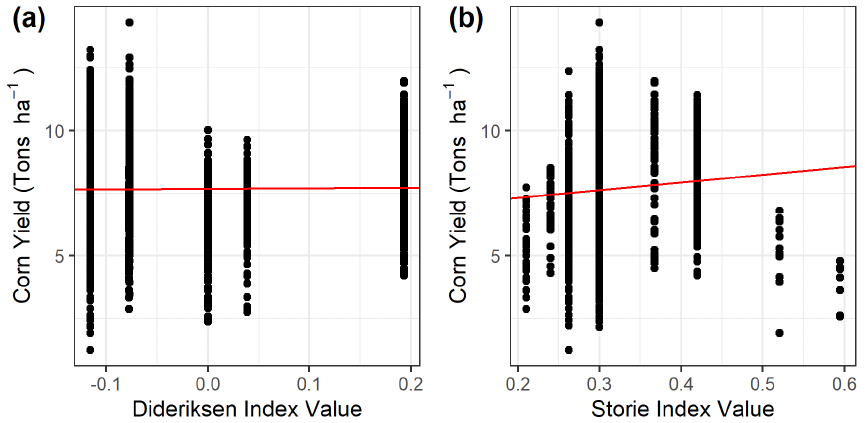
Figure 3. ( a ) Scatterplot of observed corn yield and Dideriksen index values; ( b ) Scatterplot of observed corn yield and Storie index values. Red lines represent the best fit line from a linear model of index values and observed yield.